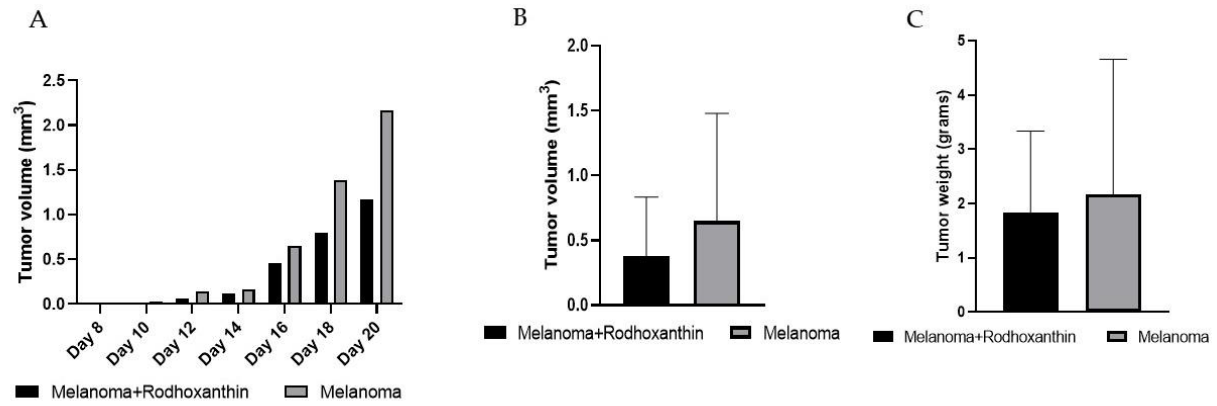
Figure 3. Effect of rhodoxanthin on solid B16F10 melanoma tumor growth in C57BL/6J mice. ( A ) Tumor volume variation throughout the study. ( B ) Significant inhibition of tumor volume between the untreated group (0.648 ± 0.829) and the treated group (0.376 ± 0.457). Each value represents the mean ± SD, n = 8). ( C ) Tumor weight inhibition at a value of 15.48% recorded after the administration of 7 mg/kg/day